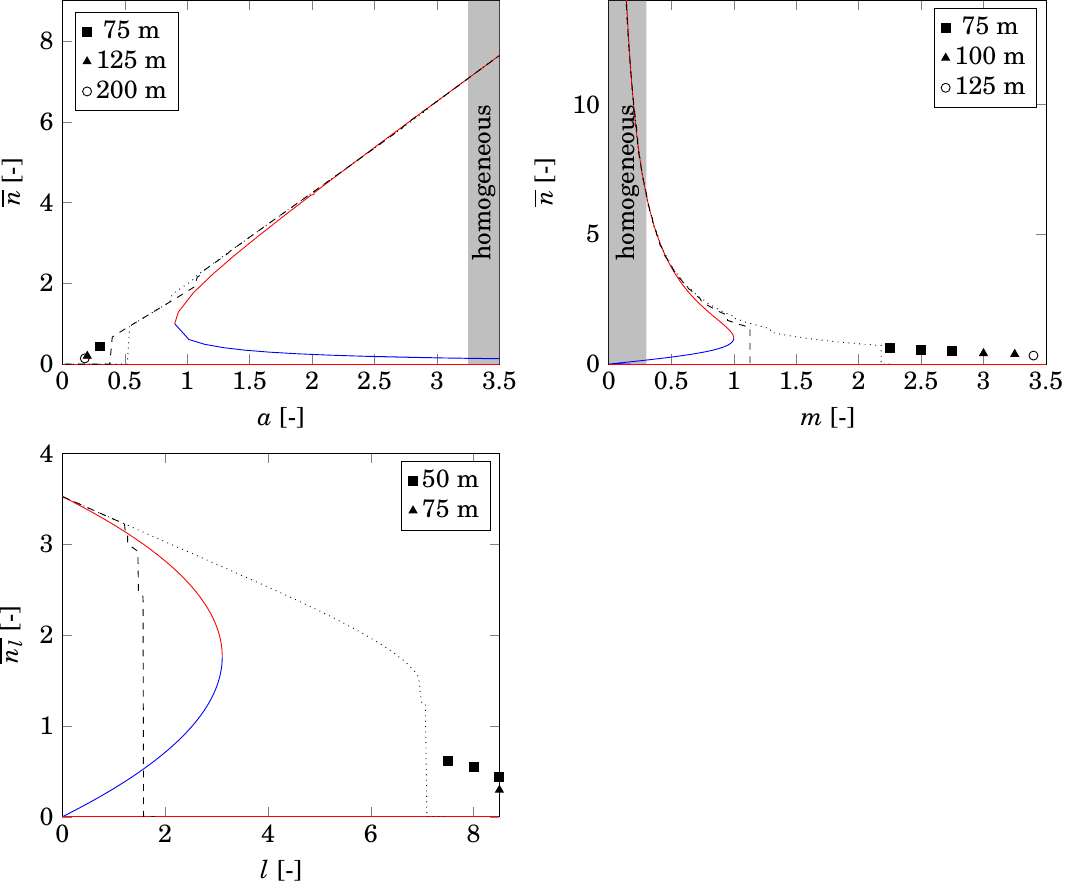
Figure 6. Bifurcation diagrams for different control parameters are shown. Red lines indicate stable equilibria, while the blue lines indicate unstable equilibria. The dashed line indicates the mean biomass with random initial conditions, while the dotted line indicates the mean biomass with four peaks as initial conditions. The square, the triangle, and the circle indicate the mean biomass for lower values of precipitation and higher values of mortality or evaporation with larger domain size and one biomass peak as initial